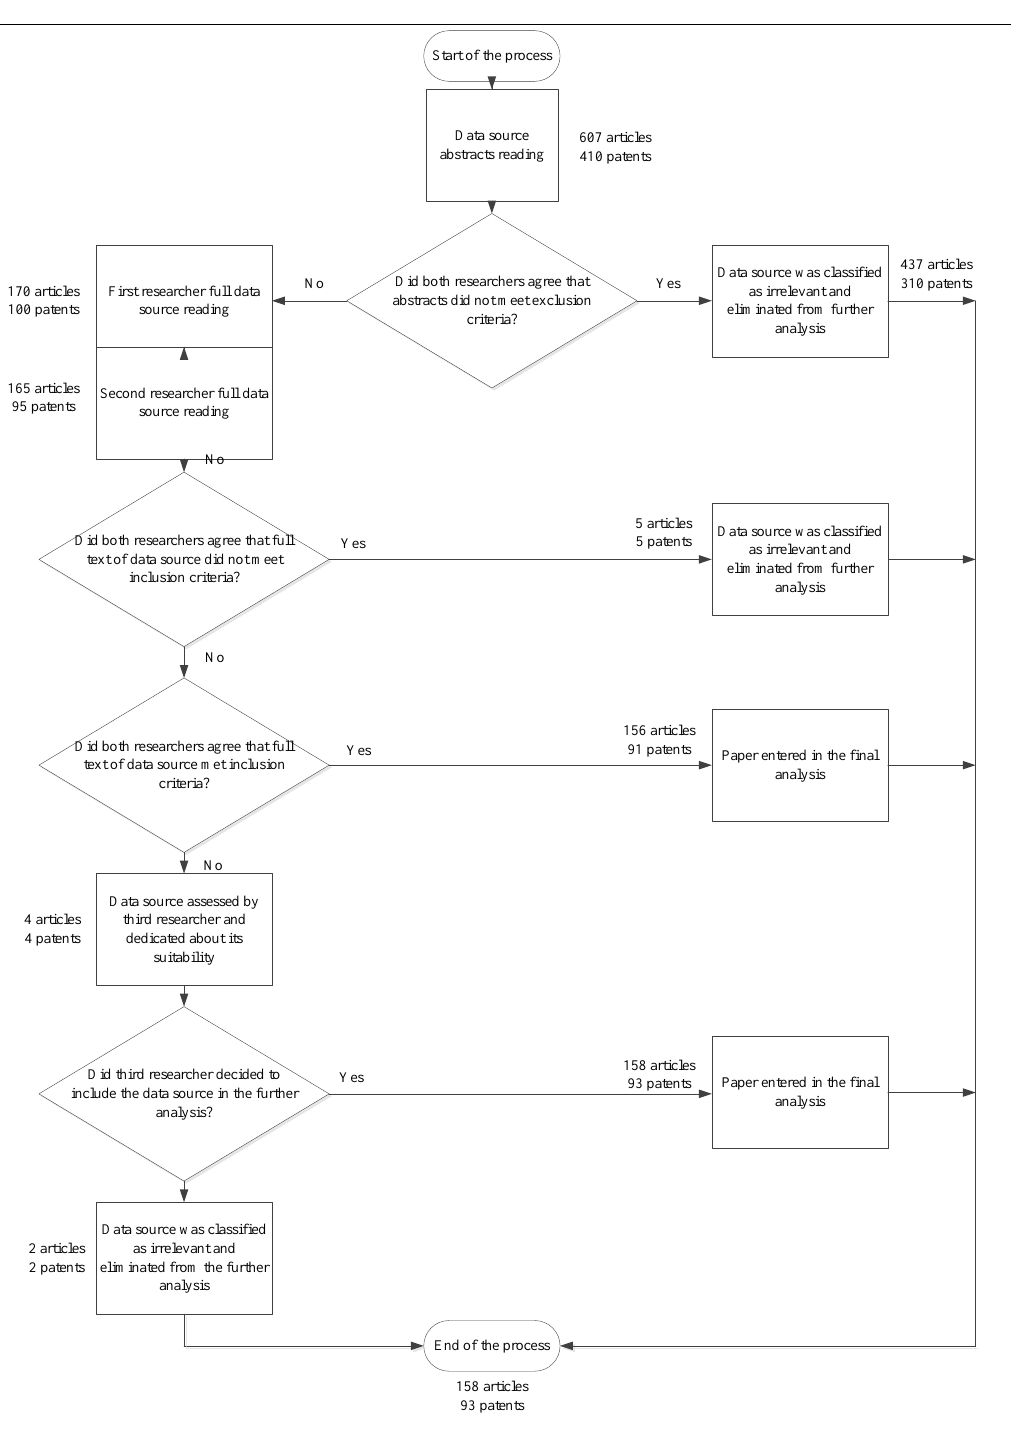
Figure 3. The data source selection process.